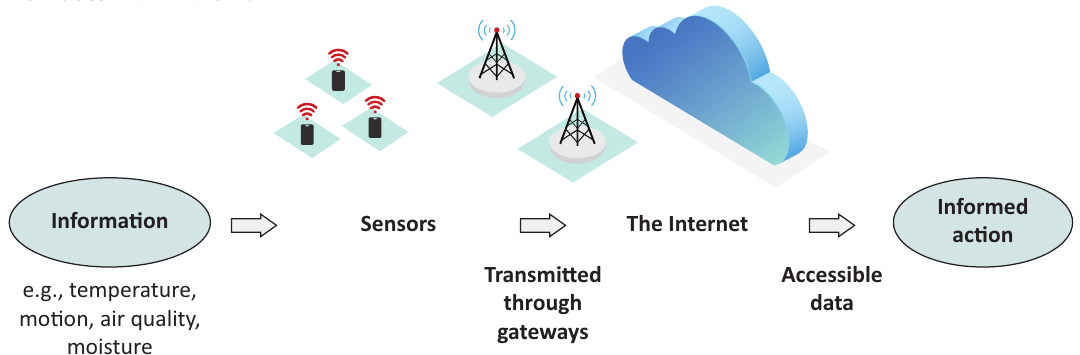
Figure 2. Description of LPWAN network from community